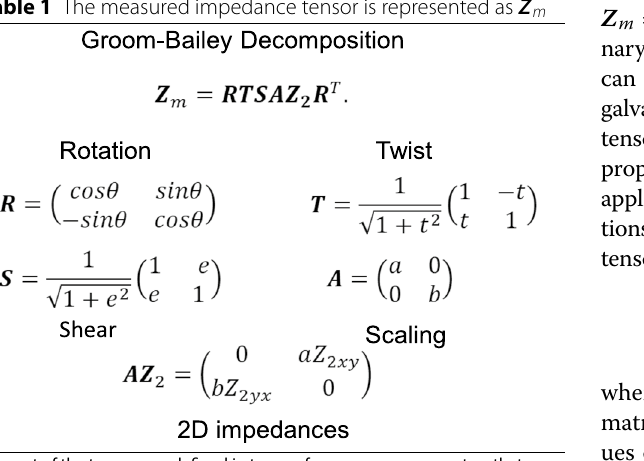
The rest of the tensors are defined in terms of one or more parameters that are to be determined in the fitting